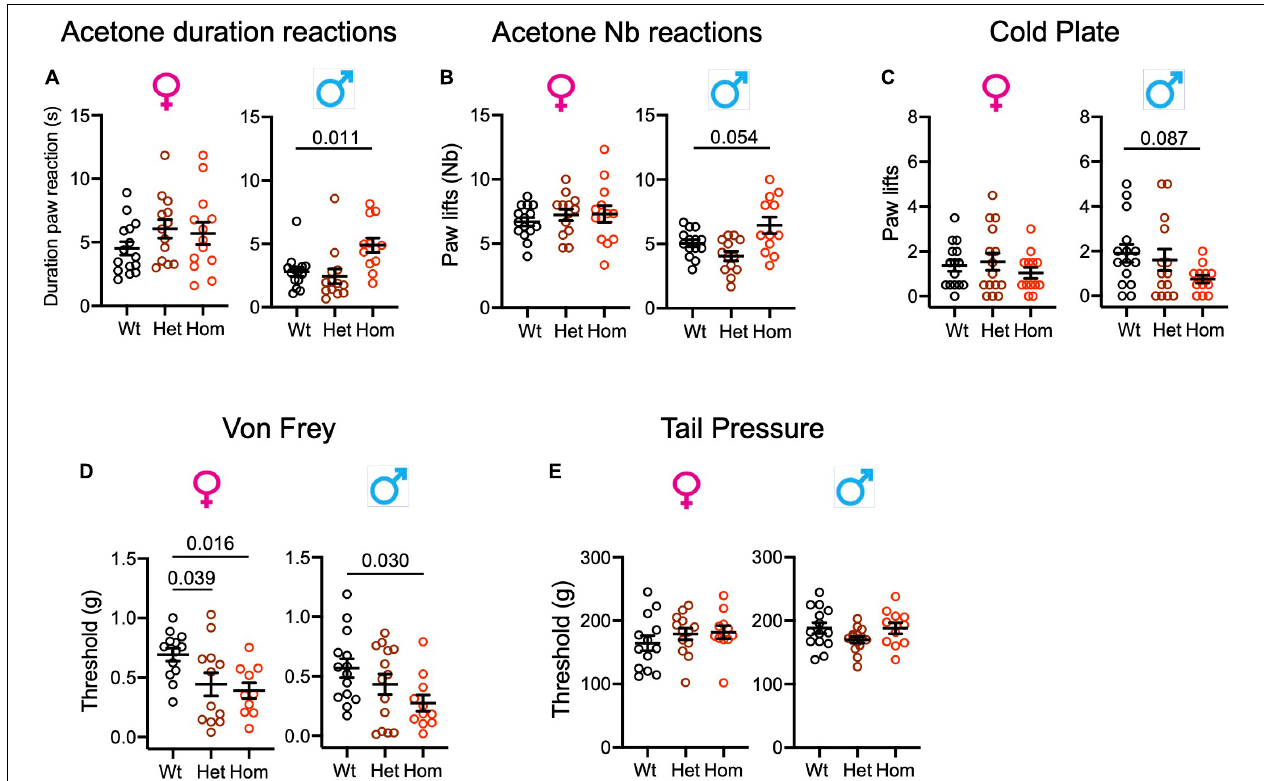
FIGURE 4 | Scn9a R 185 H mice show enhanced sensitivity to cooling and touch stimuli. (A,B) Homozygous mutant males show increased duration and number of paw reactions in the acetone test. (C) Male mutant mice show a trend to reduced number of paw lifts on the cold plate. (D) Mutant mice display lower sensitivity threshold in the von Frey test. (E) Mutant mice show no difference to wt mice in the tail pressure test. Results are shown as means ± SEM. Acetone duration of paw reactions and number of paw reactions: females: wt, n = 15; Het, n = 13; Homo, n = 13; males: wt, n = 14; Het, n = 13; Homo, n = 12. Cold plate: females: wt, n = 15; Het, n = 15; Homo, n = 13; males: wt, n = 15; Het, n = 14; Homo, n = 12. Von Frey: females: wt, n = 13; Het, n = 13; Homo, n = 10; males: wt, n = 14; Het, n = 14; Homo, n = 11. Tail pressure: females: wt, n = 13; Het, n = 13; Homo, n = 11; males: wt, n = 14; Het, n = 14; Homo, n = 11. One-way ANOVA on females and males and Dunnett’s multiple comparison tests. P -values for genotype difference are shown when significant or close to significance. See Supplementary Tables 10, 11 for